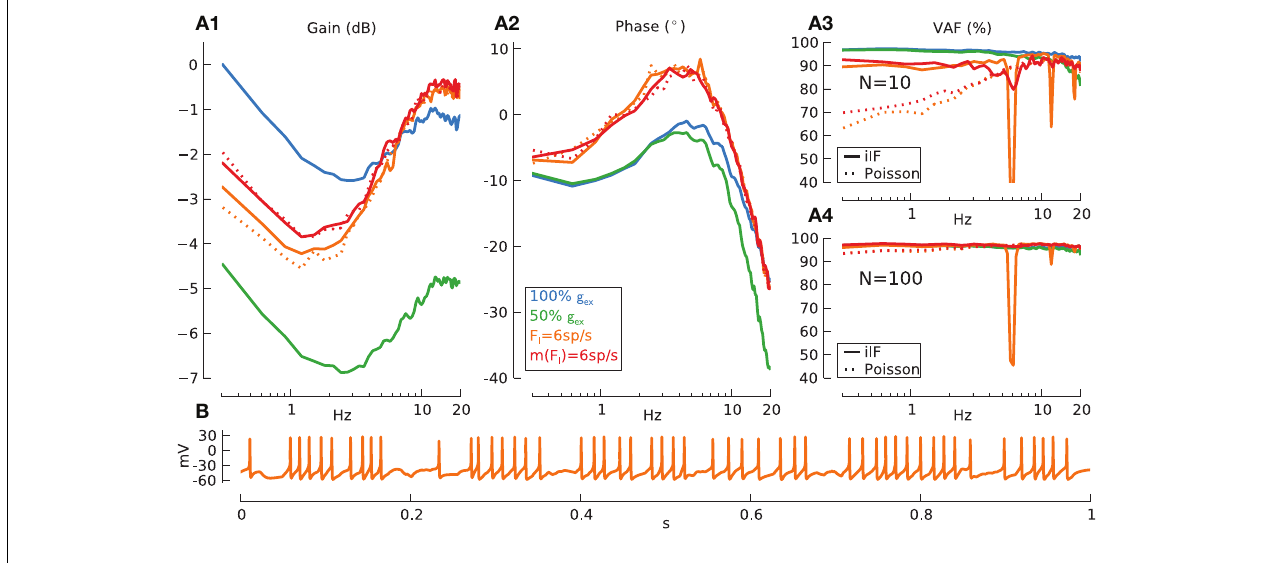
(A1–A3) (36/5.5/89.4), N = 100: (A4) (37/5.5/95.1)] and variable m ( F I ) = 6 spikes/s inhibition [red lines, N = 10: (A1–A3) (39/8.2/90.1), N = 100: (A4) (38.2/7.8/96.9)]. Input spike train encoded using iIF ( τ = ∞ ) (solid lines). Furthermore, results with inhibition coded using inhomogeneous Poisson process (dotted lines): constant inhibition F I = 6 spikes/s [dotted orange lines, N = 10: (A1–A3) (37/5.4/87.6), N = 100: (A4) (38/5.4/96.6)] and variable inhibition m ( F I ) = 6 spikes/s [dotted red lines, N = 10: (A1–A3) (40/8/88.3), N = 100: (A4) (39/7.6/96.7)]. Gain was normalized to the lowest frequency for the results from F I = 0 spikes/s and full synaptic conductance (blue solid line). (B) Membrane potential trace of respective GrC model cell in (A) with non-variable inhibition ( F I = 6